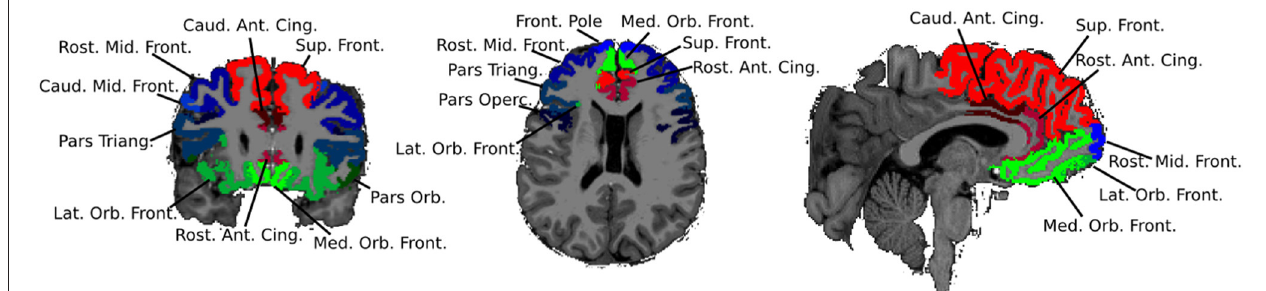
FIGURE 1 | Subdivisions of the frontal lobe.